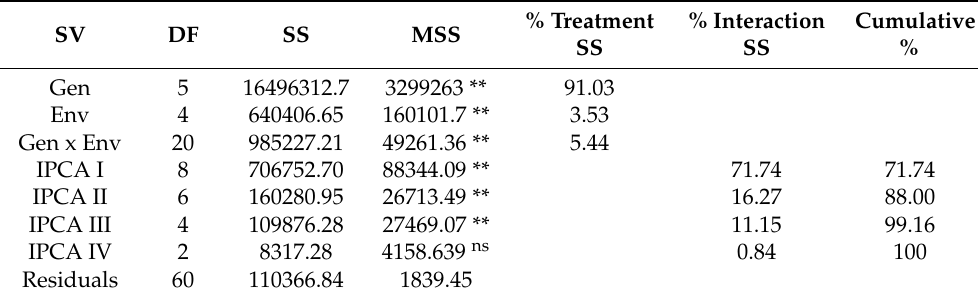
AMMI = Additive main effect and multiplicative interaction; SV = Sources of variation; DF = Degrees of freedom; SS = Sum of squares; MSS = Mean sum of squares; Gen = Genotype; Env = Environment; IPCA =